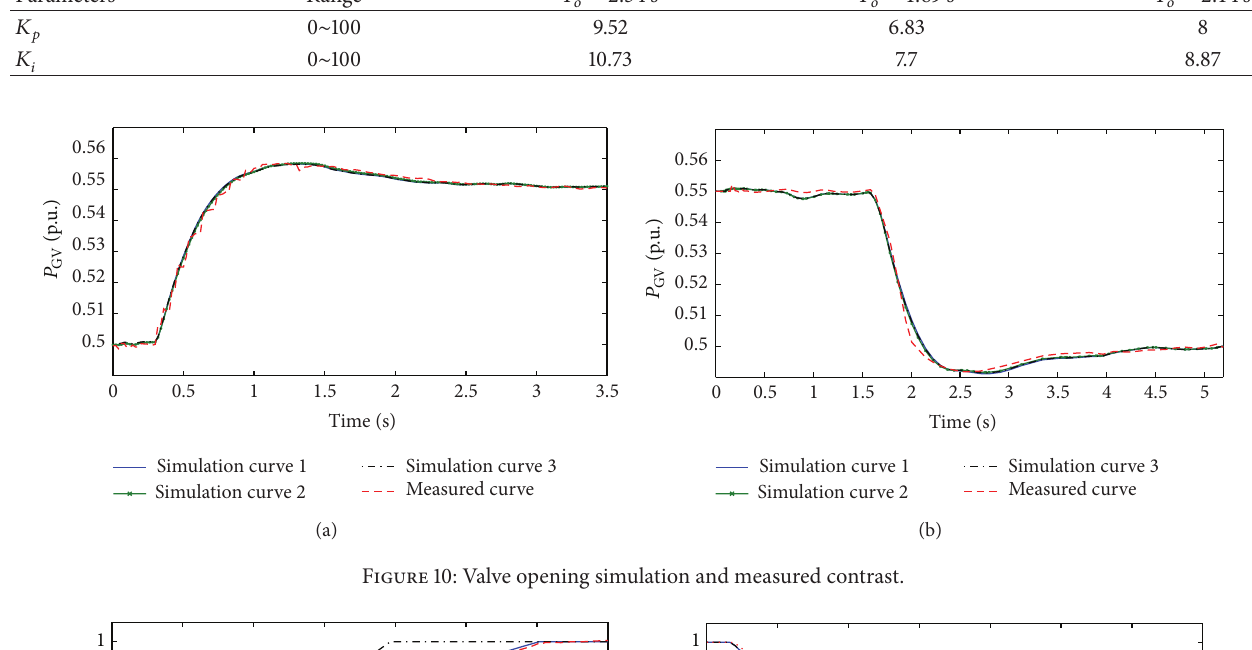
Figure 10: Valve opening simulation and measured contrast.